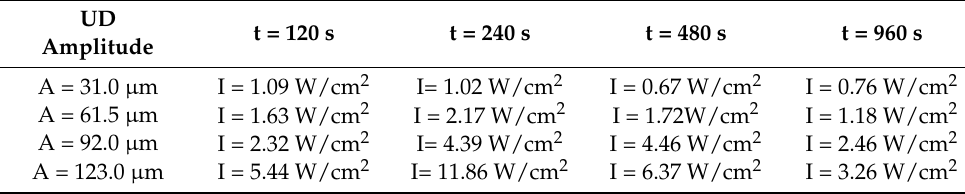
Table 3. Change in the acoustic wave intensity (I) to the sample depending on the applied amplitude and sonication